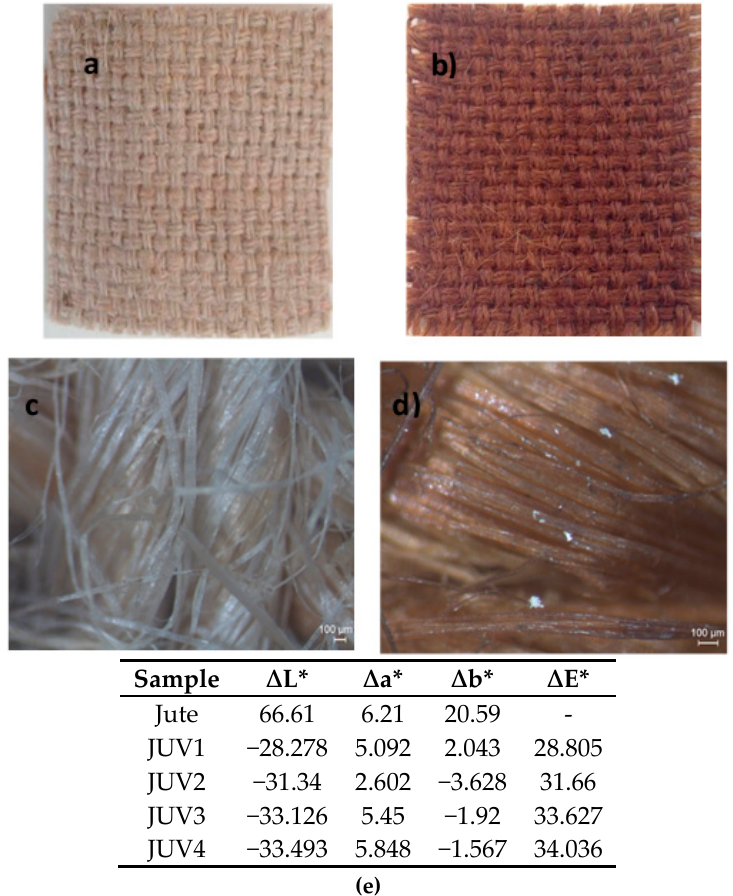
Figure 1. ( a , c ) Image of the jute fabric without functionalization; ( b , d ) jute fabric functionalized with silver nanoparticles. ( e ) CIElab color coordinates values. Table 1. Different samples prepared by the UV photoreduction process with variations in the concentration of the precursor, immersion time, and UV irradiation